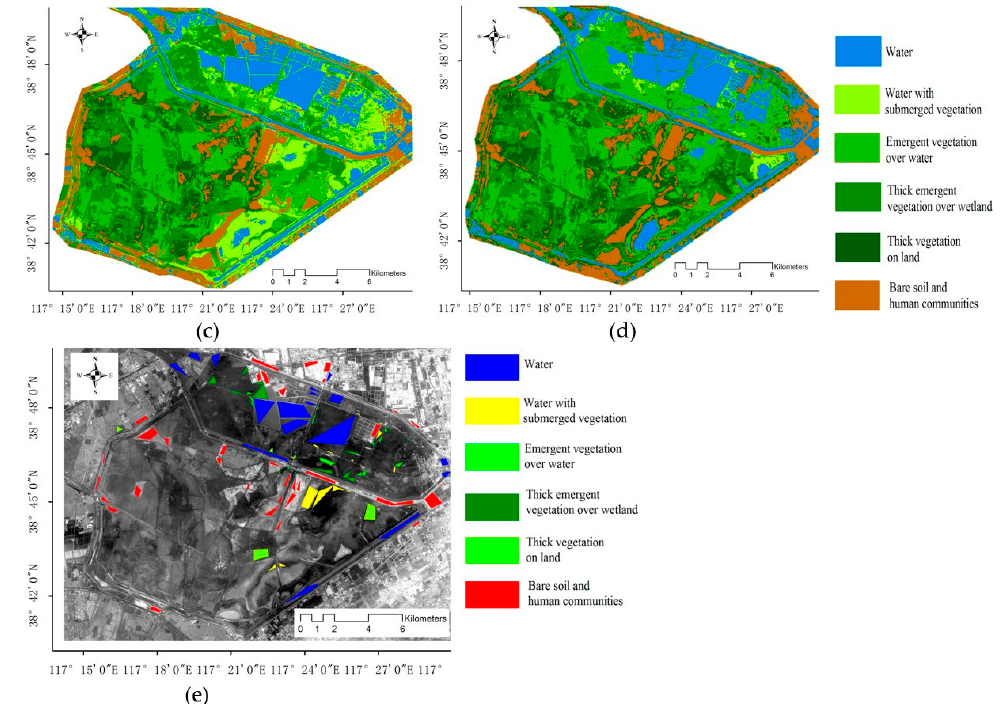
Figure 5. Classification results from different satellite multi-spectral datasets to further demonstrate the separabilty of the improved IT2FCM*: ( a ) the classification result from the ALI image of 22 August 2015; ( b ) the ground truth data collected by the field survey on 27 June 2016; ( c ) the classification result of the Sentinel-2 dataset acquired on 30 May 2016; ( d ) the classification result of the Landsat 8 remote sensing imagery acquired on 29 May 2016; and ( e ) the ground truth data collected by the field survey on 27 June